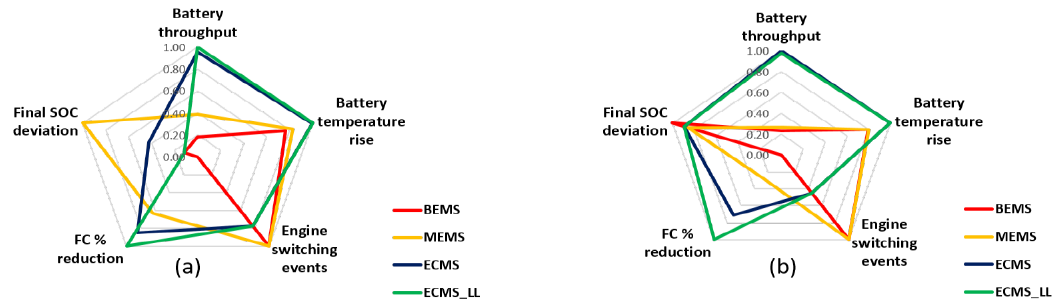
Figure 13. Simulation results for the Veh 1 configuration considered: ( a ) WMTC test cycle and ( b ) IDC test cycle.